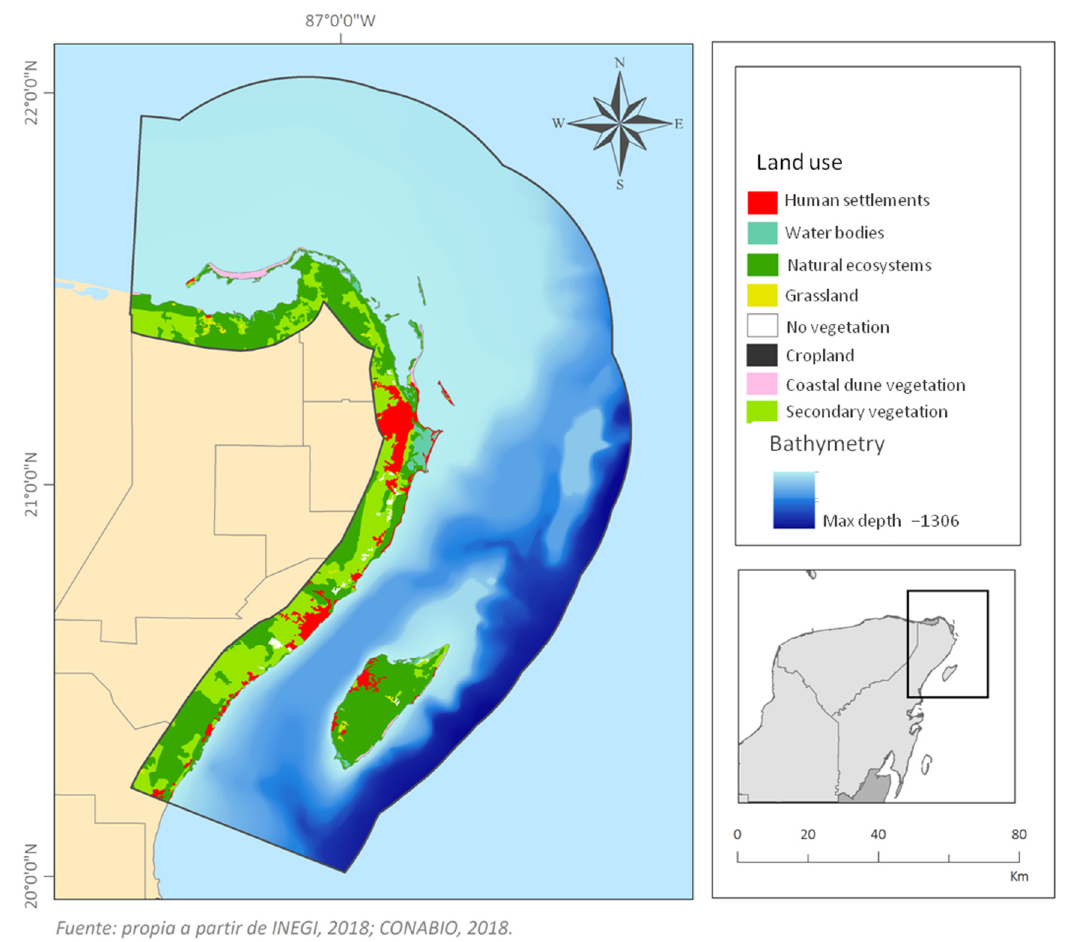
Figure 2. Biophysical characteristics.